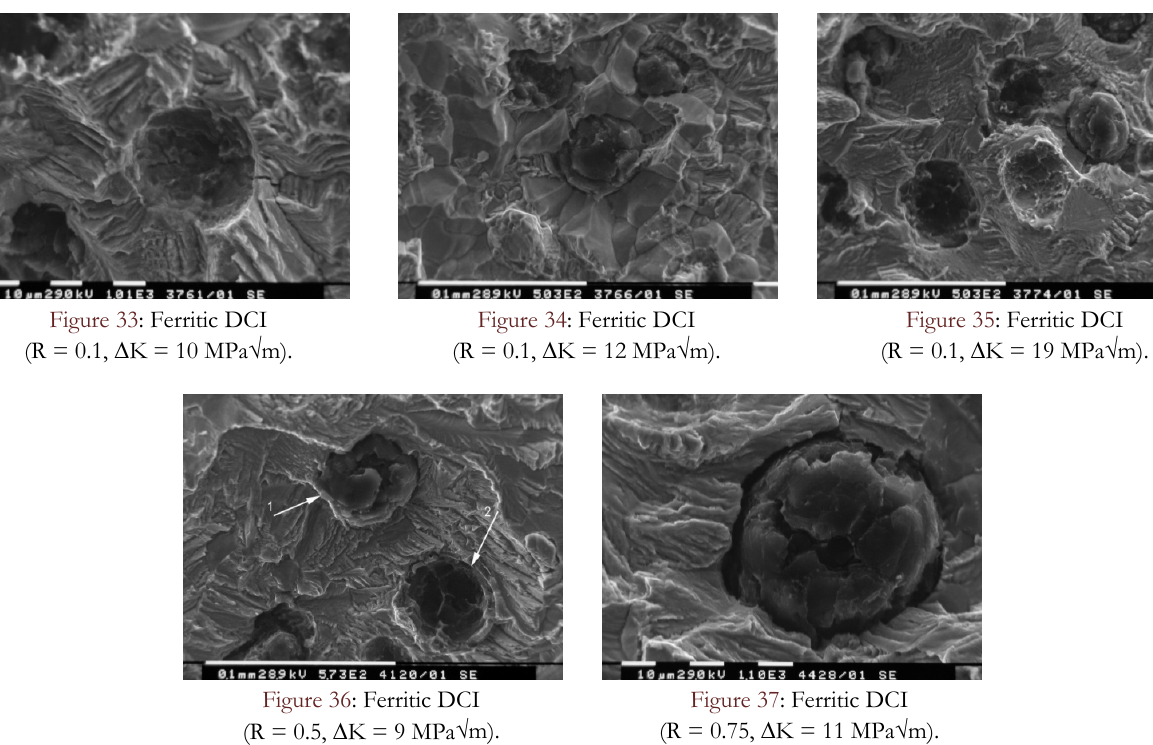
Figure 36: Ferritic DCI (R = 0.5,  K = 9 MPa √ m).